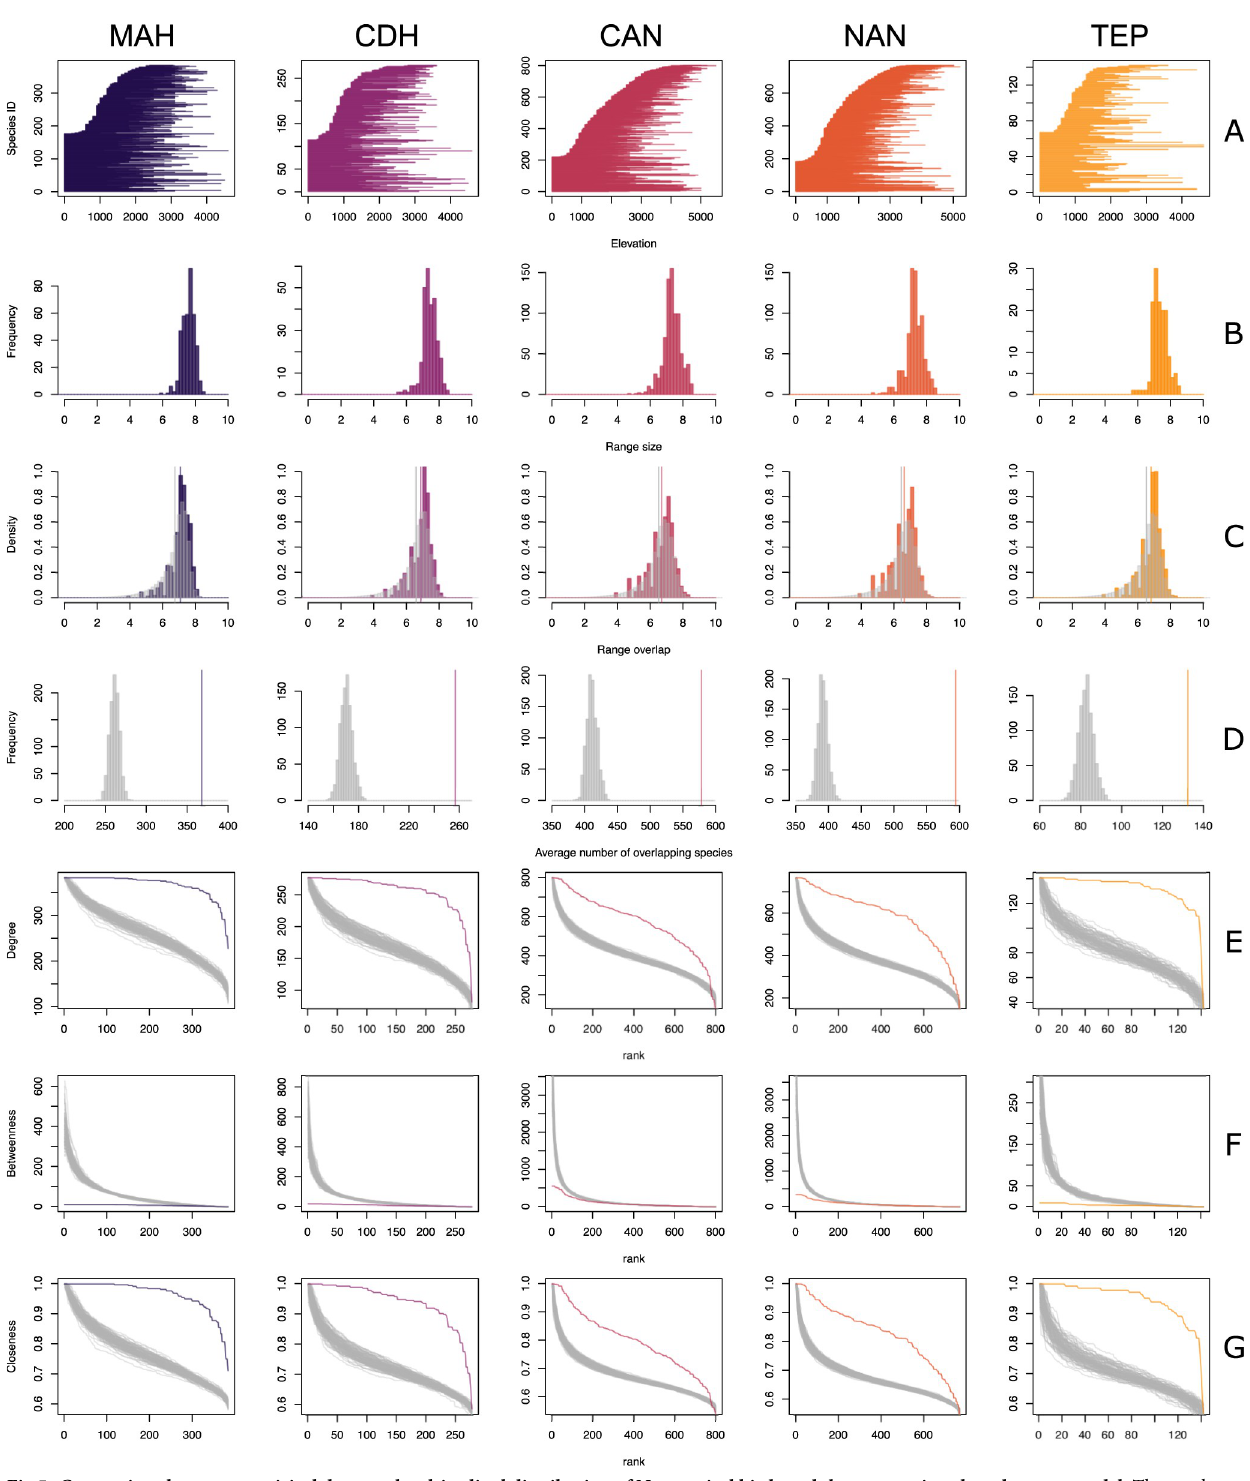
Fig 5. Comparison between empirical data on the altitudinal distribution of Neotropical birds and the expectations based on our model. The results showed are of simulations without truncation. Locations are: Madrian Highlands (MAH) (N = 384 species), Chiriquı´-Darie´n Highlands (CDH) (N = 278 species), Central Andes (CAN) (N = 801 species), Northern Andes (NAN) (N = 768 species), and Tepuis (TEP) (N = 142 species): (A) altitudinal distribution of the species in each location, ranked according to the lowest limit to facilitate visualization; (B) altitudinal range size distribution; (C) altitudinal range overlap distribution (gray histogram indicates the expectation of the range overlap distribution based on 100 model simulations using mean and standard